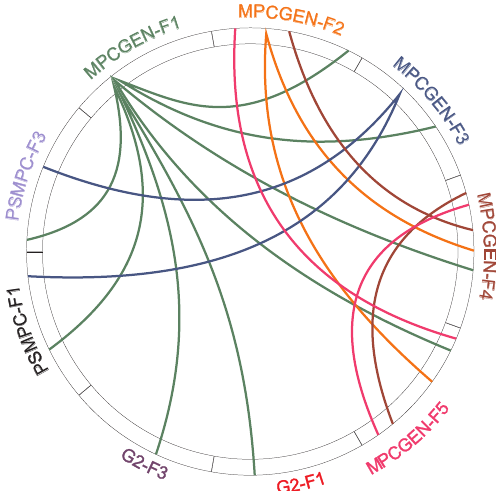
Figure 11. Overlapping MPCGEN malware families.